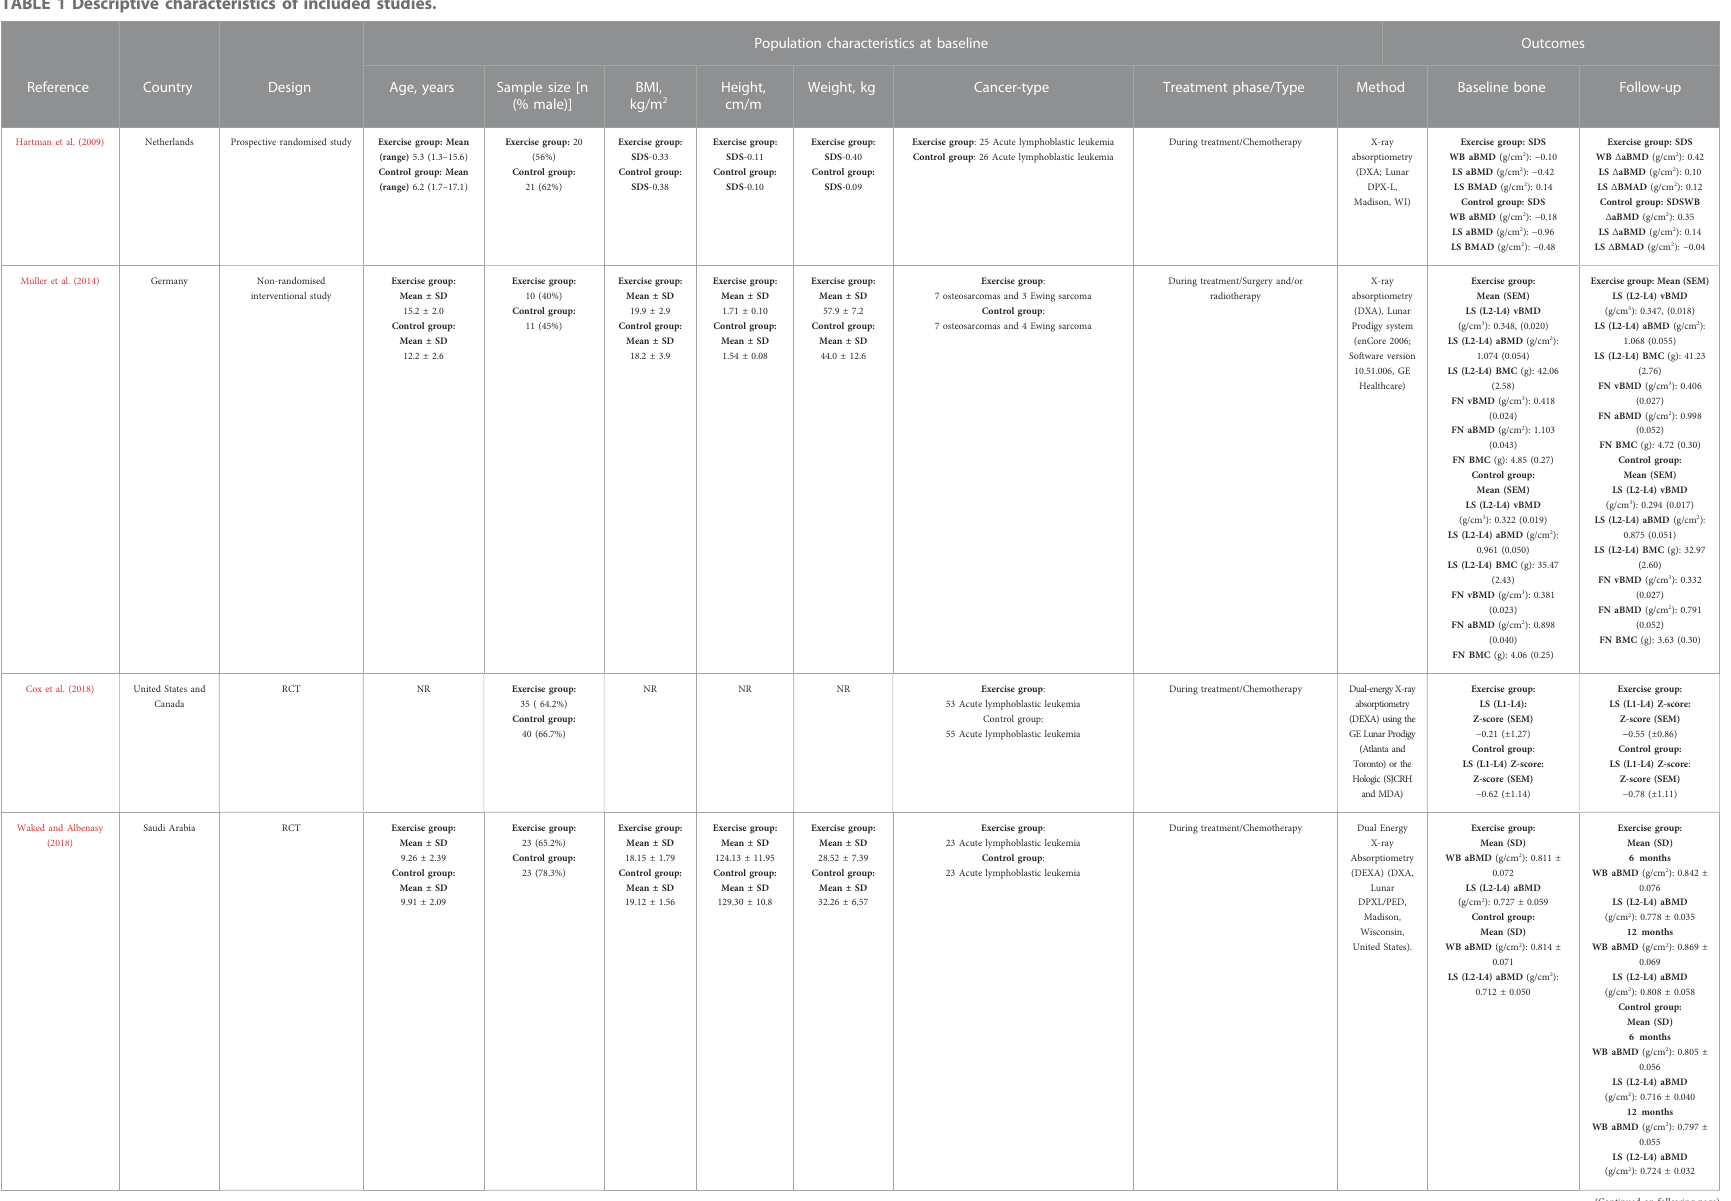
TABLE 1 Descriptive characteristics of included